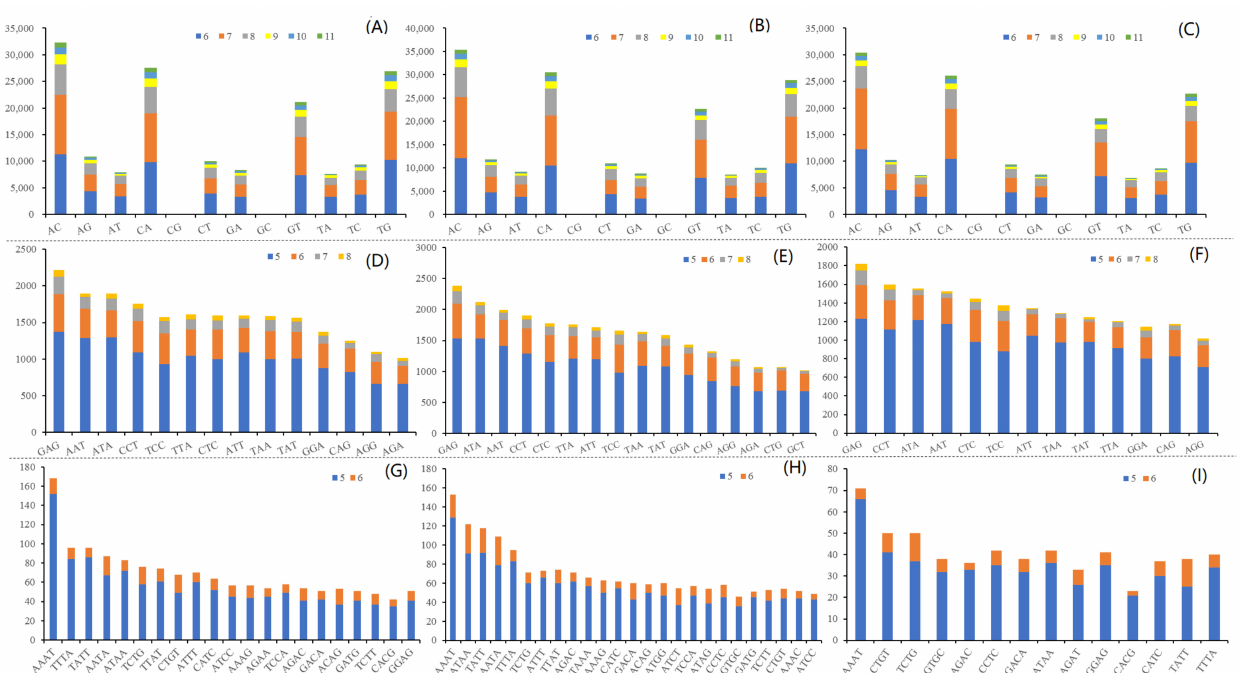
Figure 4. The distribution of identified microsatellite motifs. ( A – C ) Frequency of different dinucleotide microsatellite motifs. ( D – F ) Frequency of different trinucleotide microsatellite motifs (>1000). ( G – I ) Frequency of different tetranucleotide microsatellite motifs (>40). The squares in different colors with particular numbers represent different repeat times.